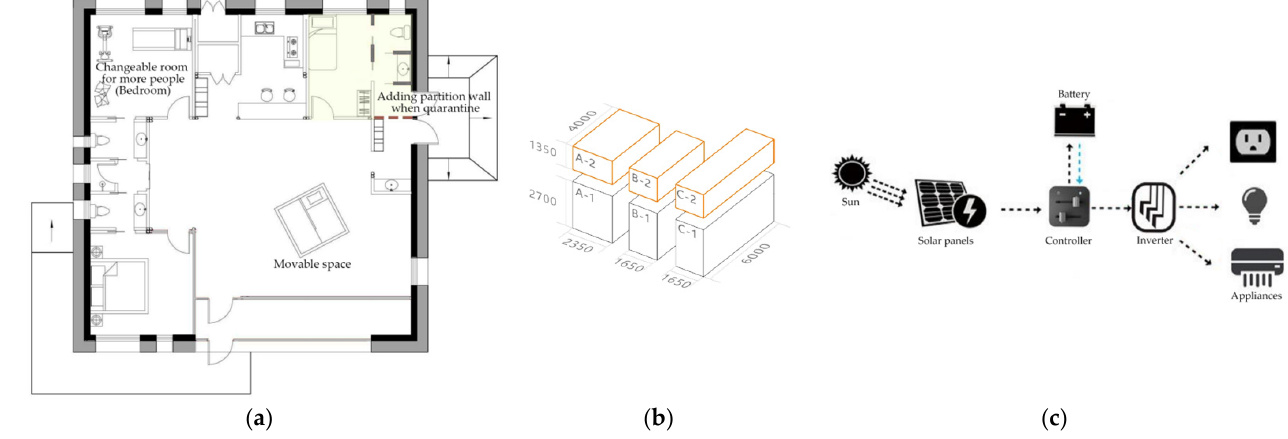
Figure 4. Main results of the 24 × 35 Housing Home. ( a ) Flexible space. ( b ) Transportation module. ( c ) Renewable energy system.